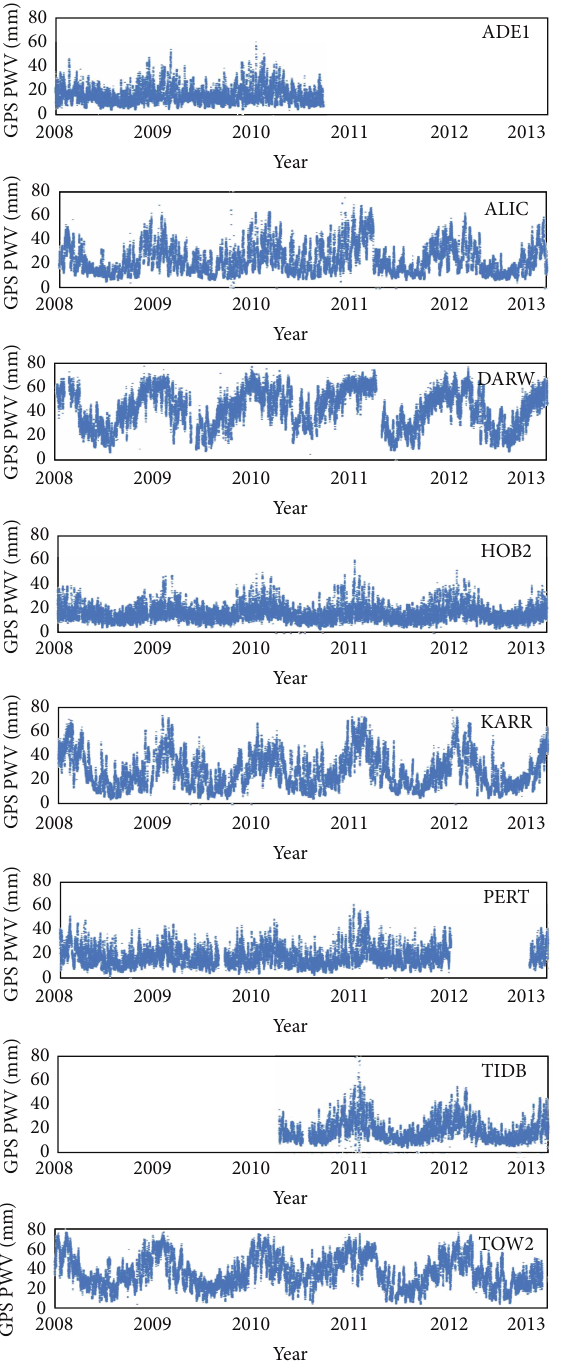
station (see Figure 1). The spatial and temporal variability of PWV concentration in the atmosphere depends on the season, topography, and other local/regional climate condi- tions. In Figure 7, the 5-year absolute PWV estimates from GPS are plotted, where available, as time series. The time series display strong annual variation in PWV at all sites, with distinctive peaks and dips occurring approximately at